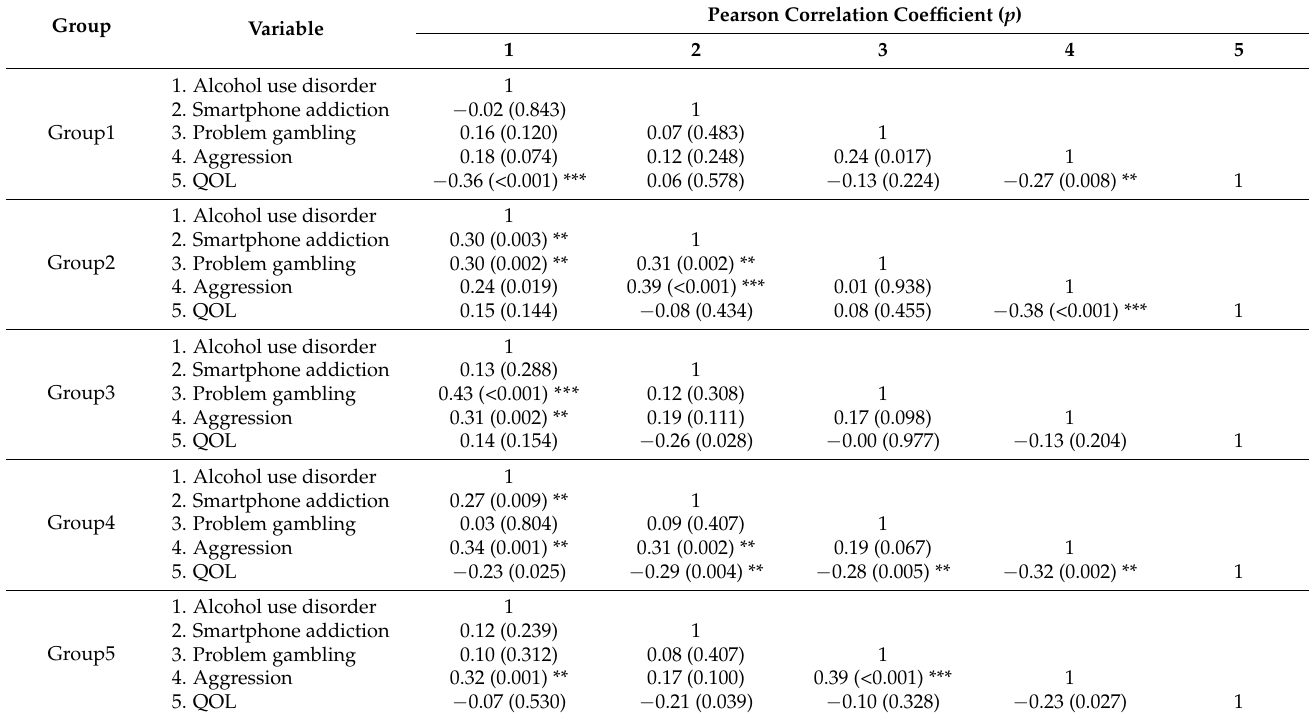
Table 4. Correlations of variables by